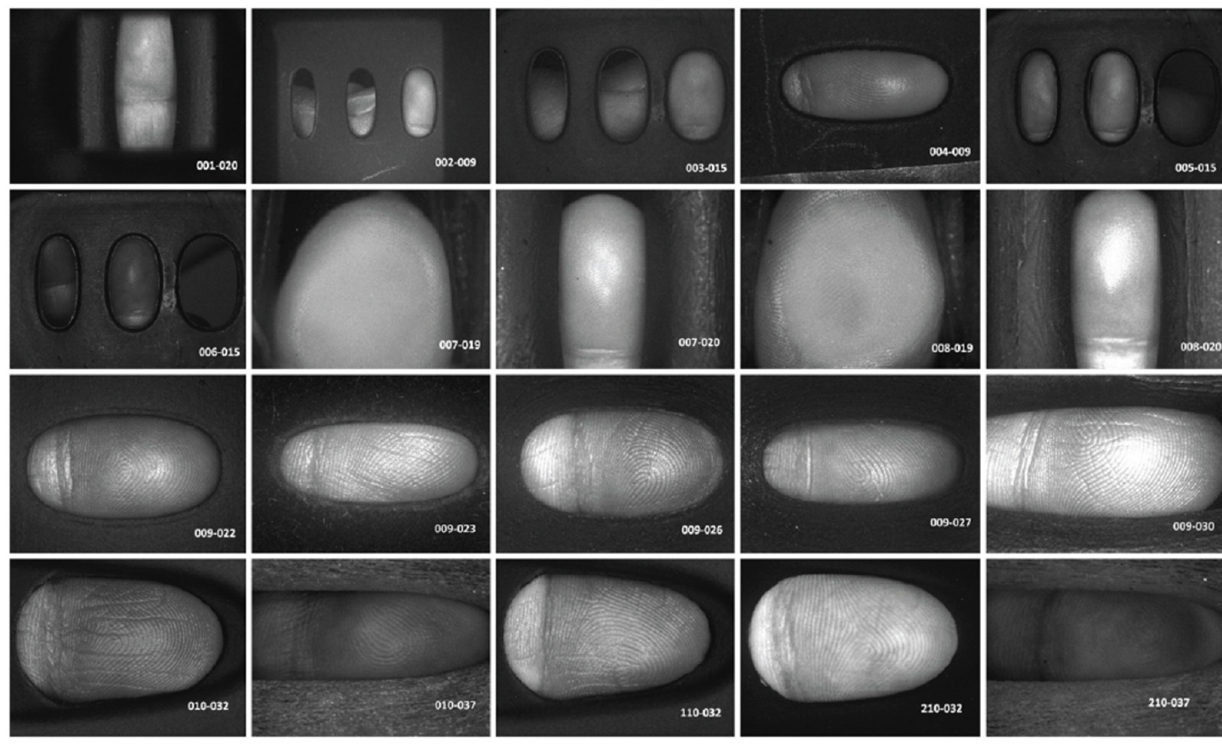
Figure 12. Imaging of fingers interacting with various top designs.